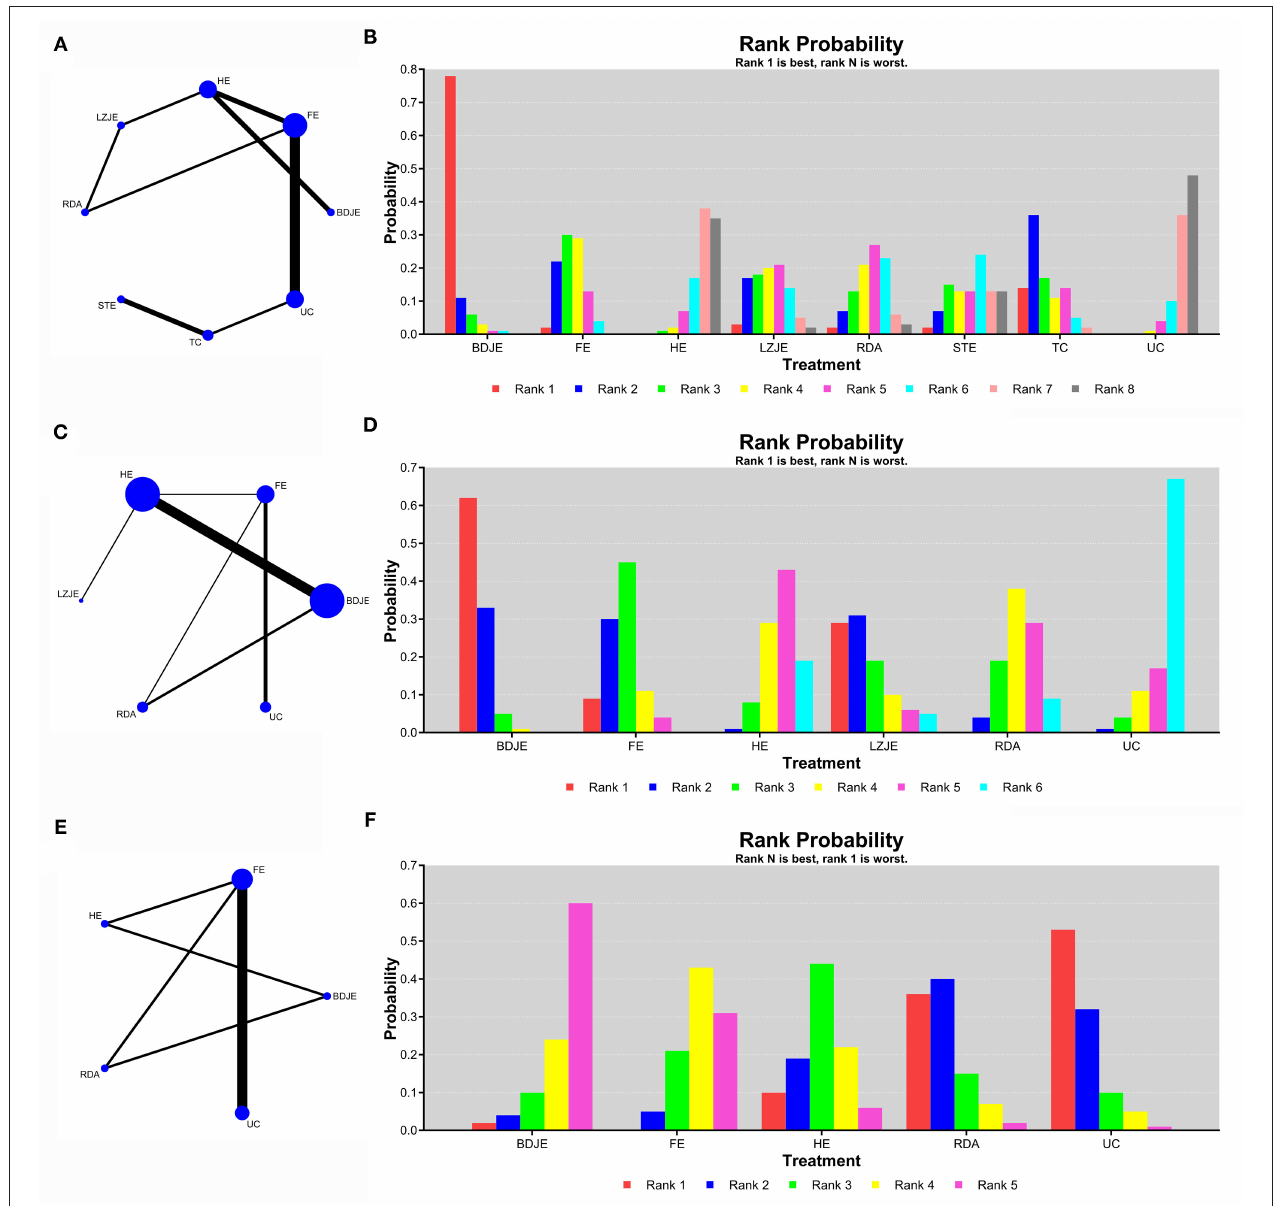
FIGURE 3 | The network comparisons for the outcome of MMSE (A) , MoCA (C) and ADL (E) . The ranking probability of MMSE (B) , MoCA (D) and ADL (F) . BDJE, Baduanjin exercise; FE, finger exercise; HE, health education; LZJE, Liuzijue exercise; RDA, routine daily activities; STE, stretching and toning exercise; TC, Tai Chi; UC, usual